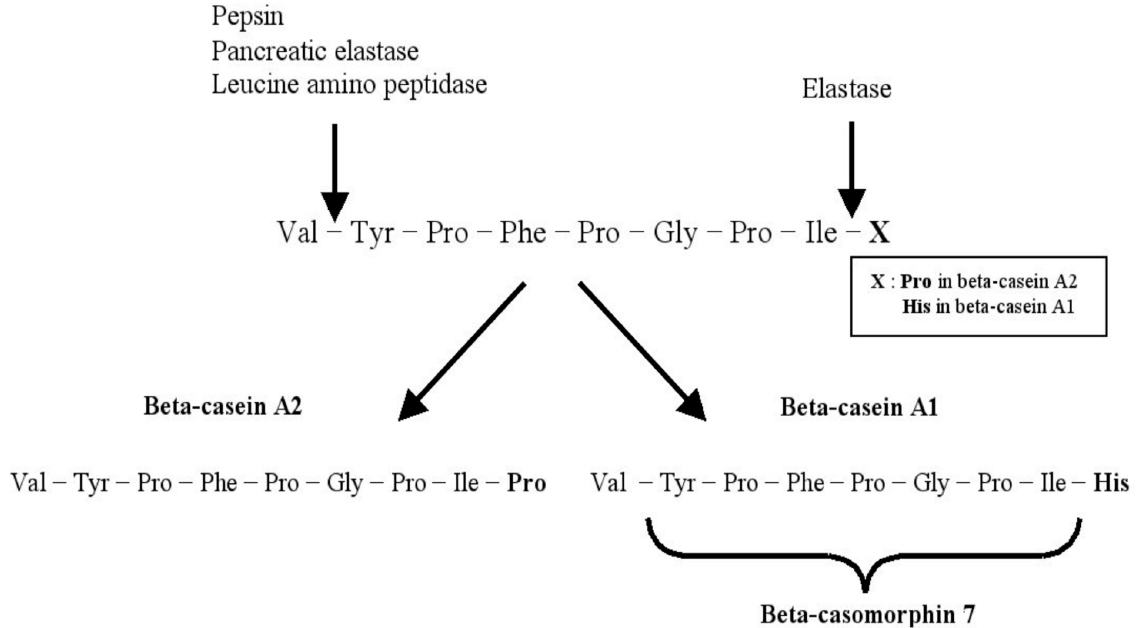
Figure 1. Release of beta-casomorphin-7 from beta-casein variant A1 but not from A2 (adapted from [14,36]). Table 3. In vitro gastrointestinal digestion of β‐ casein variants using pepsin and pancreatic enzymes 1 .